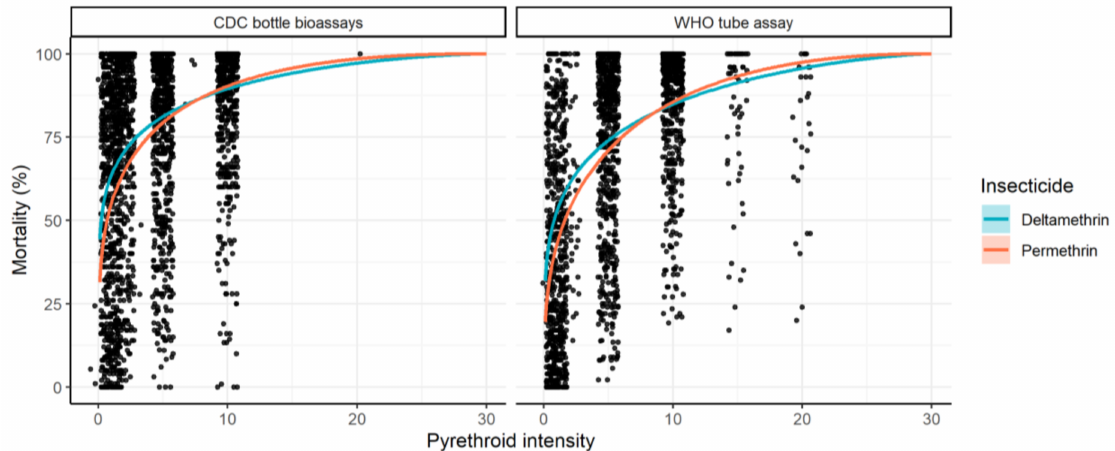
Figure 10. Overview of the intensity bioassay data used for analysis: points represent raw mortality data at each respective insecticide intensity with the modelled dose-response curve shown by Table 1 at 1 × , 2 × , 5 × , 10 × , 15 × , or 20 ×